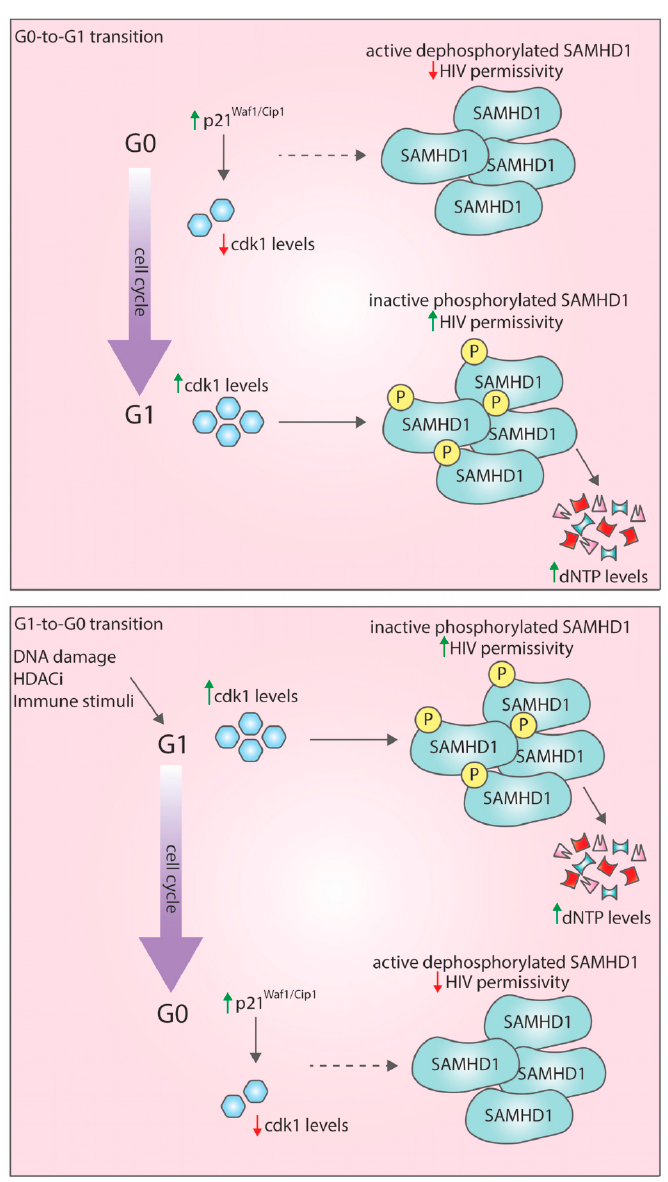
Figure 1. G0-to-G1 transition presents a window of opportunity for HIV-1 infection. G0-to-G1 transition: Macrophages in the G0 state express the negative cell cycle regulator p21(Waf1/Cip1).